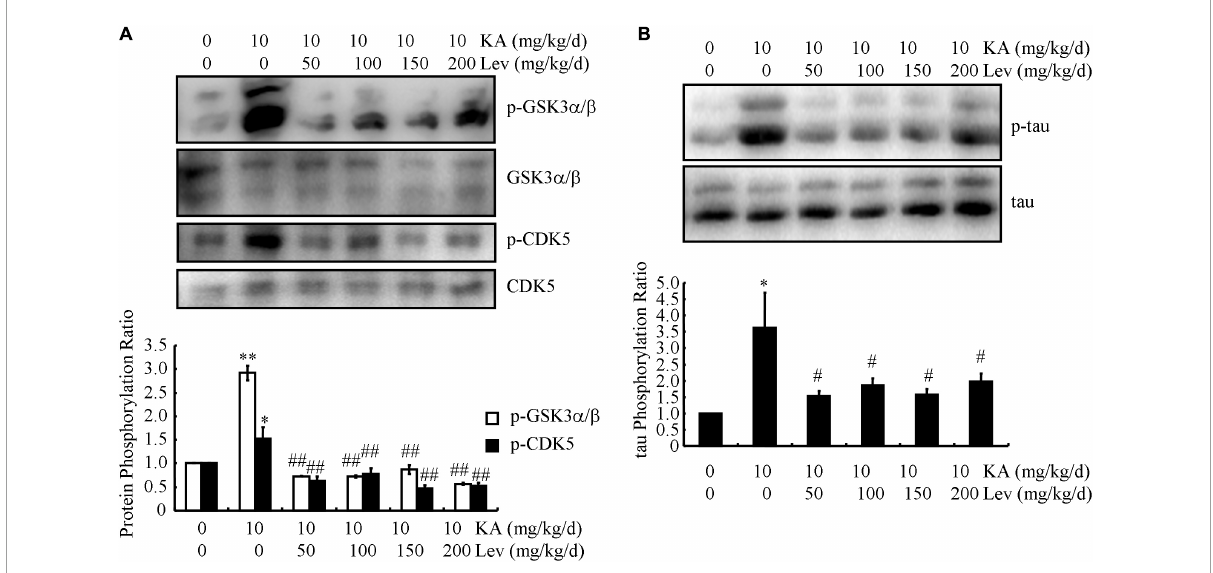
FIGURE4 LEV suppresses KA-induced tau phosphorylation in the brains of APP23/MAPT mice. (A) Phosphorylated and total protein levels of GSK3 α / β and CDK5 in the brains of KA (10 mg/kg/d)- or LEV (50, 100, 150, or 200 mg/kg/d) + KA-treated APP23/MAPT mice, as determined by western blots. (B) Phosphorylated and total protein levels of tau in the brains of KA- or LEV (50, 100, 150, or 200 mg/kg) + KA-treated APP23/MAPT mice, as determined by western blots. The optical densities of bands in the western blots were evaluated using the ImageJ software ( ∗ P < 0.05; ∗∗ P < 0.01 vs. the control group; # P < 0.05; ## P < 0.01 vs. the KA-only group, one-way ANOVA). KA, kainic acid; LEV, levetiracetam; A β , amyloid β